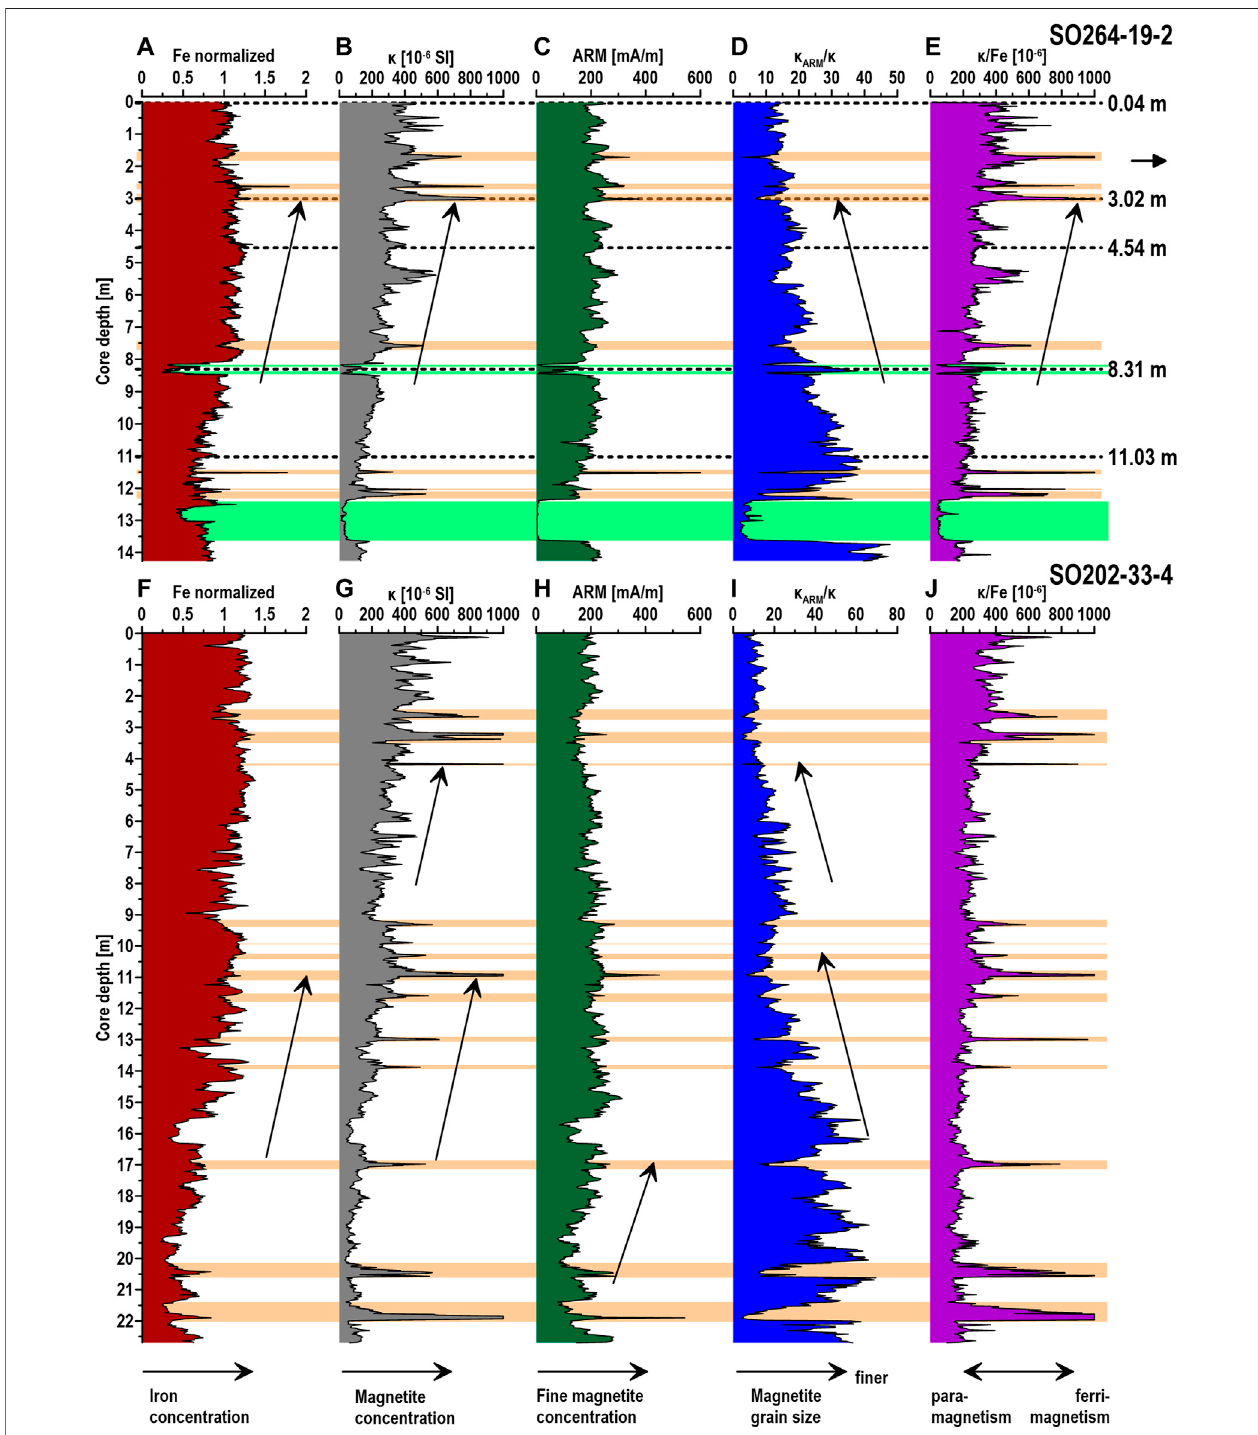
FIGURE2| Down-core rock magnetic records ofcoresSO264-19 – 2(top) and SO202-33 – 4(bottom). Green horizontalbars:magnetite dissolution layers; orange bars: tephra or volcaniclastic layers (A,F) : Relative Fe content derived from XRF core scans. (B,G) : Discrete sample volume susceptibility (C,H) : Anhysteretic remanent magnetization ARM. (D,I) : Magnetogranulometric κ ARM / κ ratio. (E,J) : Mineral magnetic κ /Fe ratio. Dashed horizontal lines mark positions of the fi ve samples used for FORC and SEM/TEM analyses. Black arrows indicate prominent signal trends.